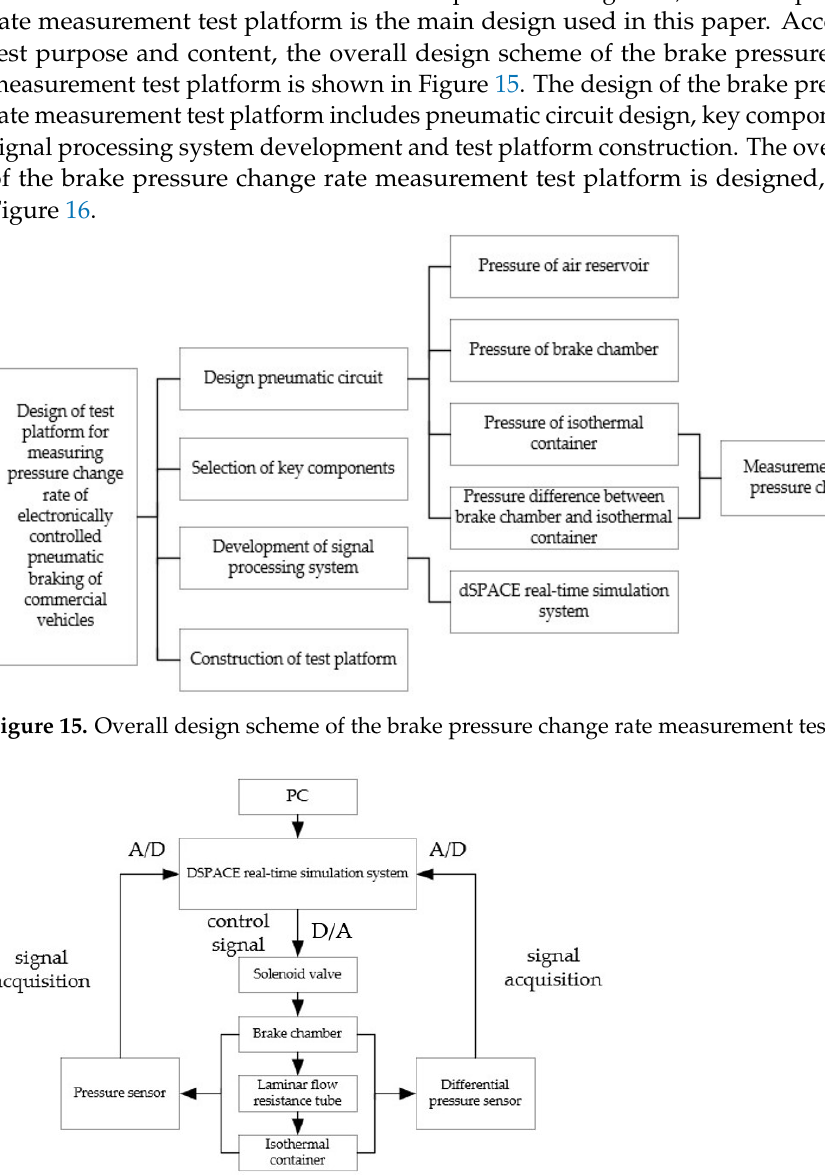
Figure 14. Simulation results of brake pressure change rate considering temperature change.